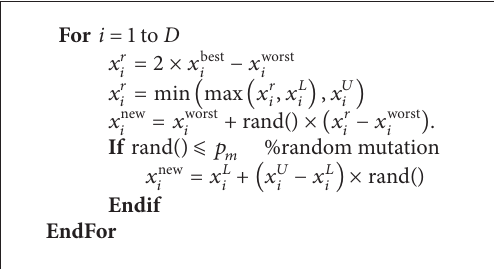
Algorithm 2: The improvisation procedure of new harmony by